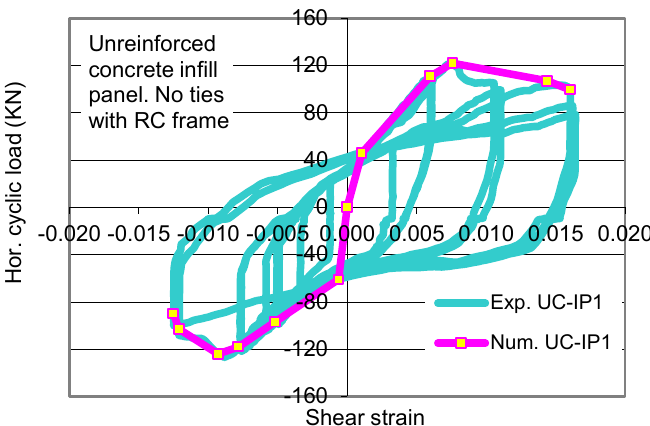
Figure 22. Horizontal displacement versus horizontal load cyclic response of specimen UC-IP 1. Comparison between observed and numerically predicted behaviour.